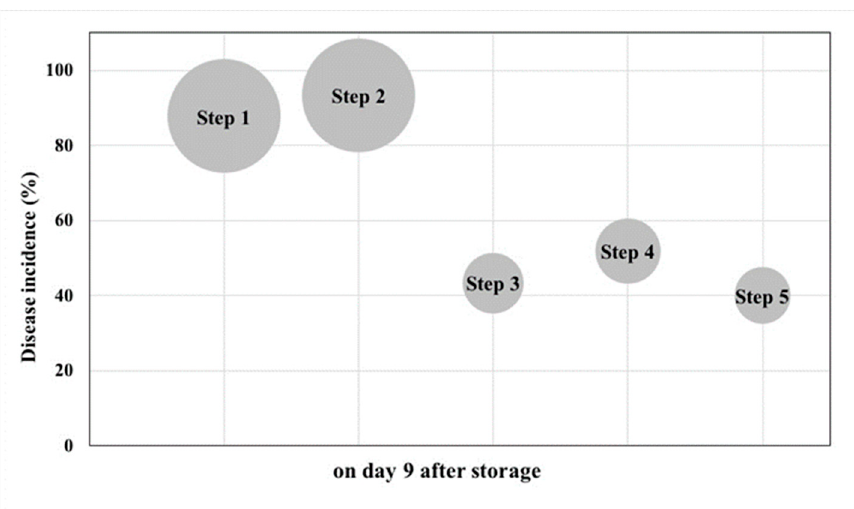
Figure 5 . Anthracnose disease incidence and severity of mangoes from each step during handling process in the packing house of pilot export company . Size of the circle indicates the infected area on the surface of inspected mangoes .